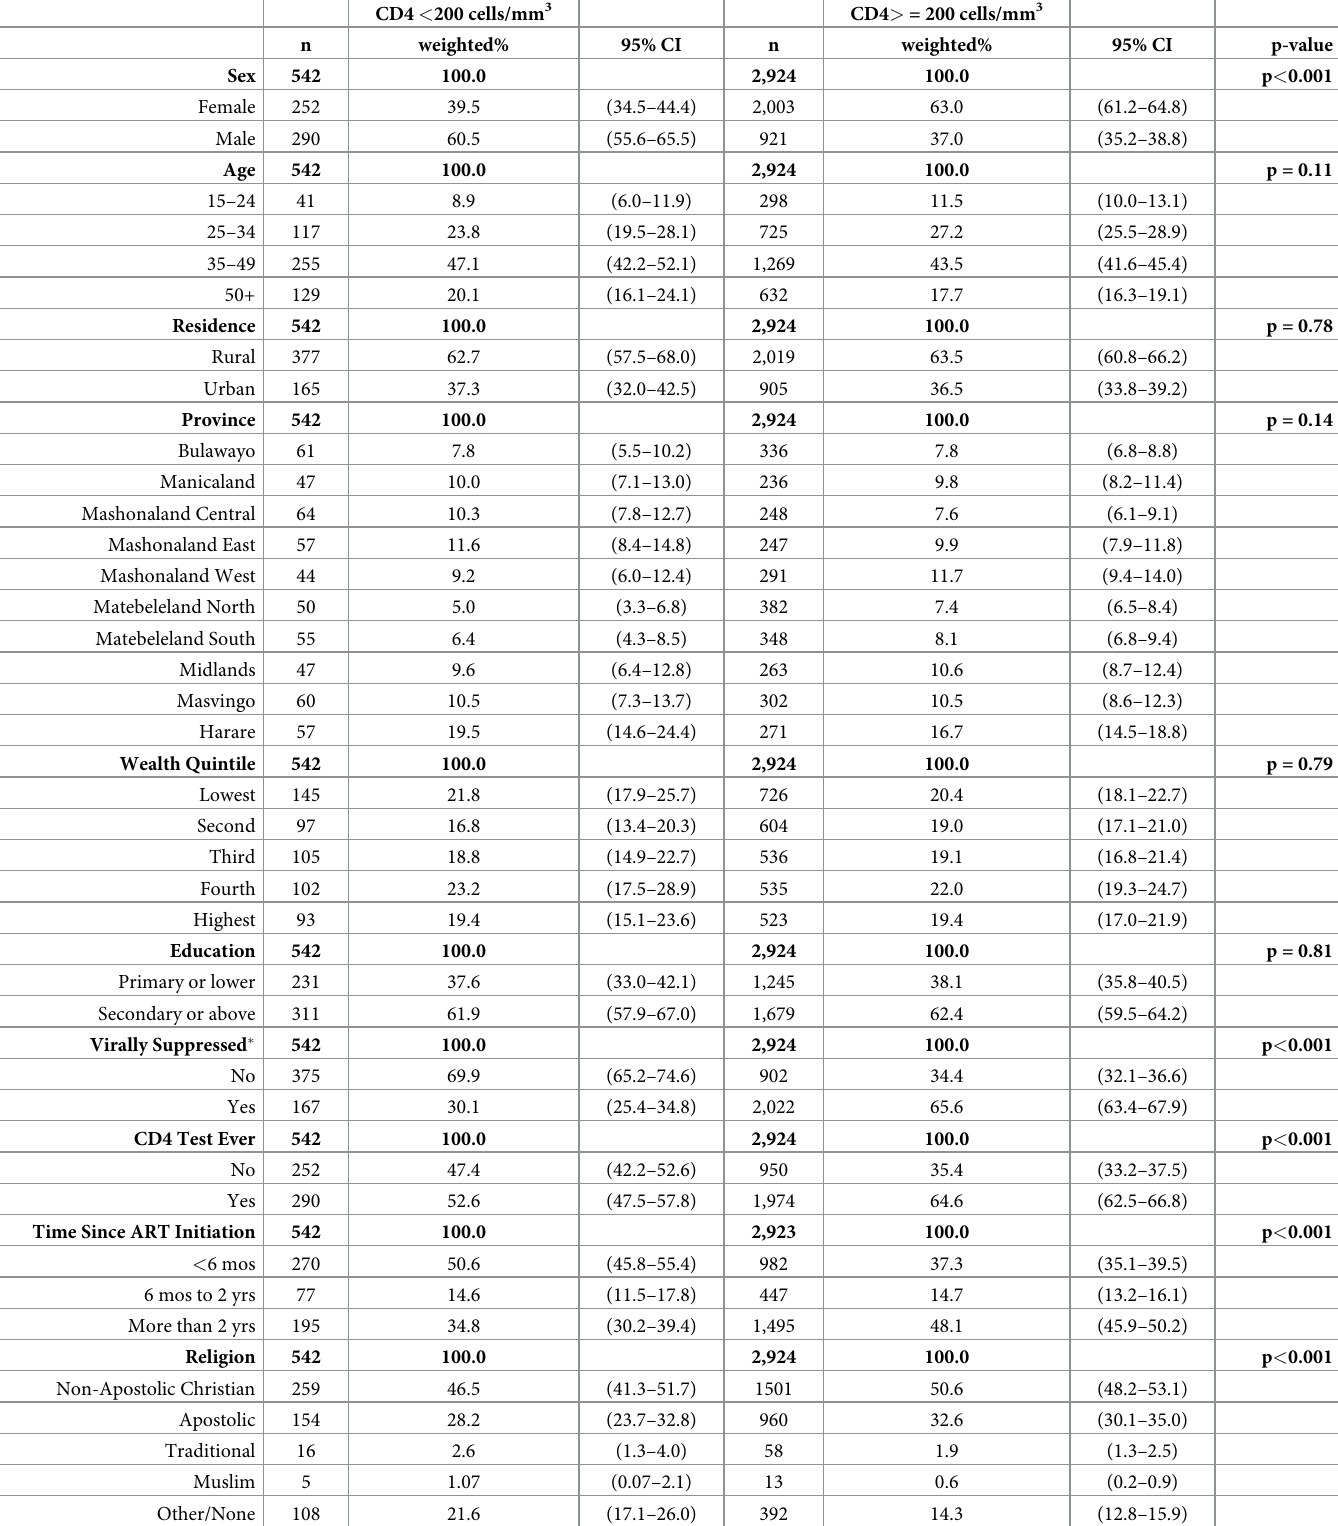
Table 1. Characteristics of ZIMPHIA 2015–16 HIV-positive study population disaggregated by CD4